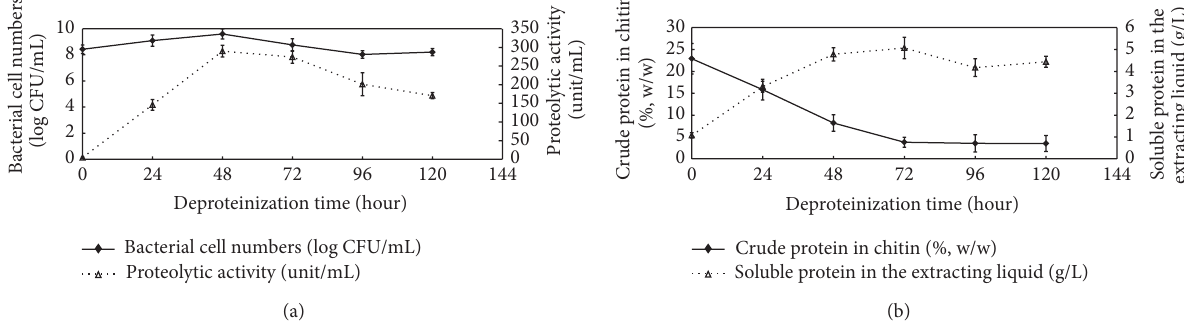
Figure 3: Deproteinization of decalcified shrimp shells by B. thuringiensis SA.